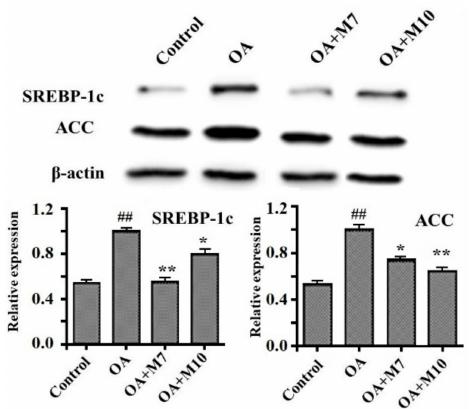
Figure 7. E ff ects of VIAPW (M7) and IRWWW (M10) from miiuy croaker ( M. miiuy ) muscle on the expression levels of proteins of SREBP-1c and ACC associated with lipid metabolism in HepG2 cells. Means ± SD (n = 3) are used to express the experiment data. ## p < 0.01 versus normal control group; ** p < 0.01 and * p < 0.05 versus OA model